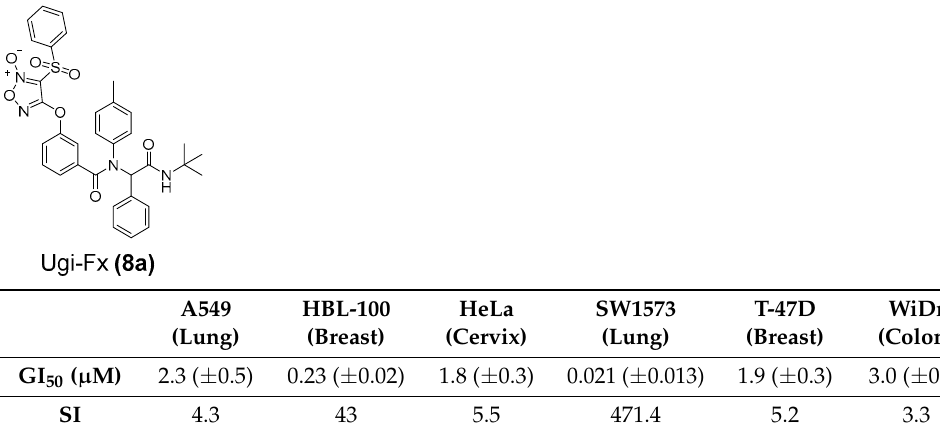
Table 1. Structure of ⋅ NO-donor Ugi derivative 8a with antiproliferative activity against six cancer cells lines and its selectivity index (SI) in comparison to the non-cancer HaCaT human cells [9].